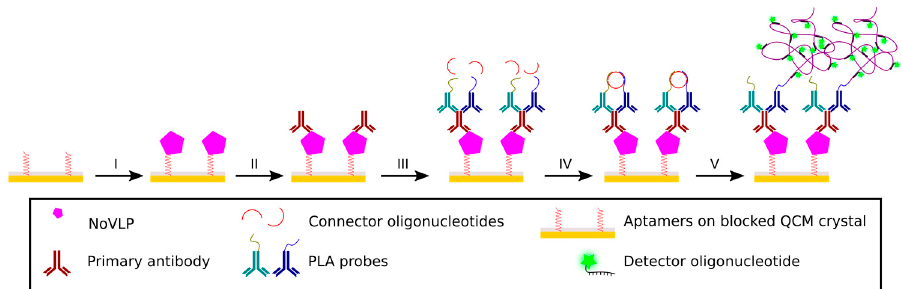
Figure 2. Principle of the sandwich-type PLA. An aptamer-based capture of NoVLPs on QCM surface (I—aptamer functionalization & blocking), followed by binding of mouse monoclonal antibodies (II— primary Ab) and anti-mouse antibodies conjugated to short oligonucleotides (III—PLA probes) form